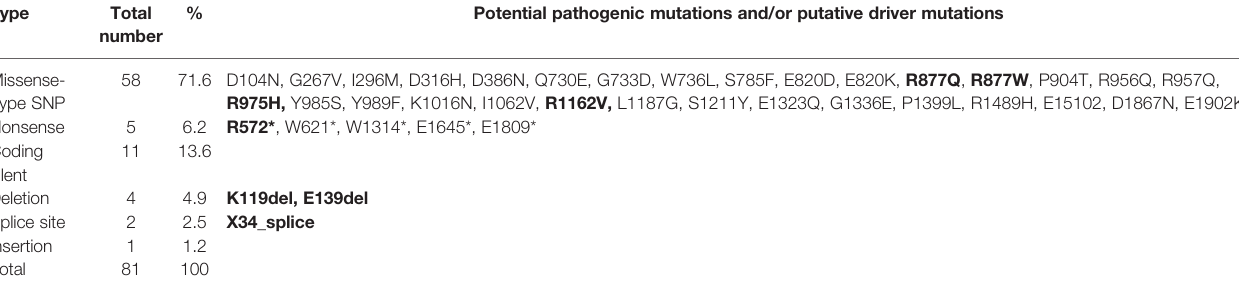
In bold are highlighted the putative driver mutations in CHD4. *stop